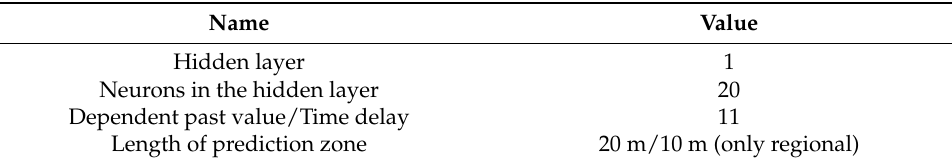
Table 4. Parameter setting of the NARNN.